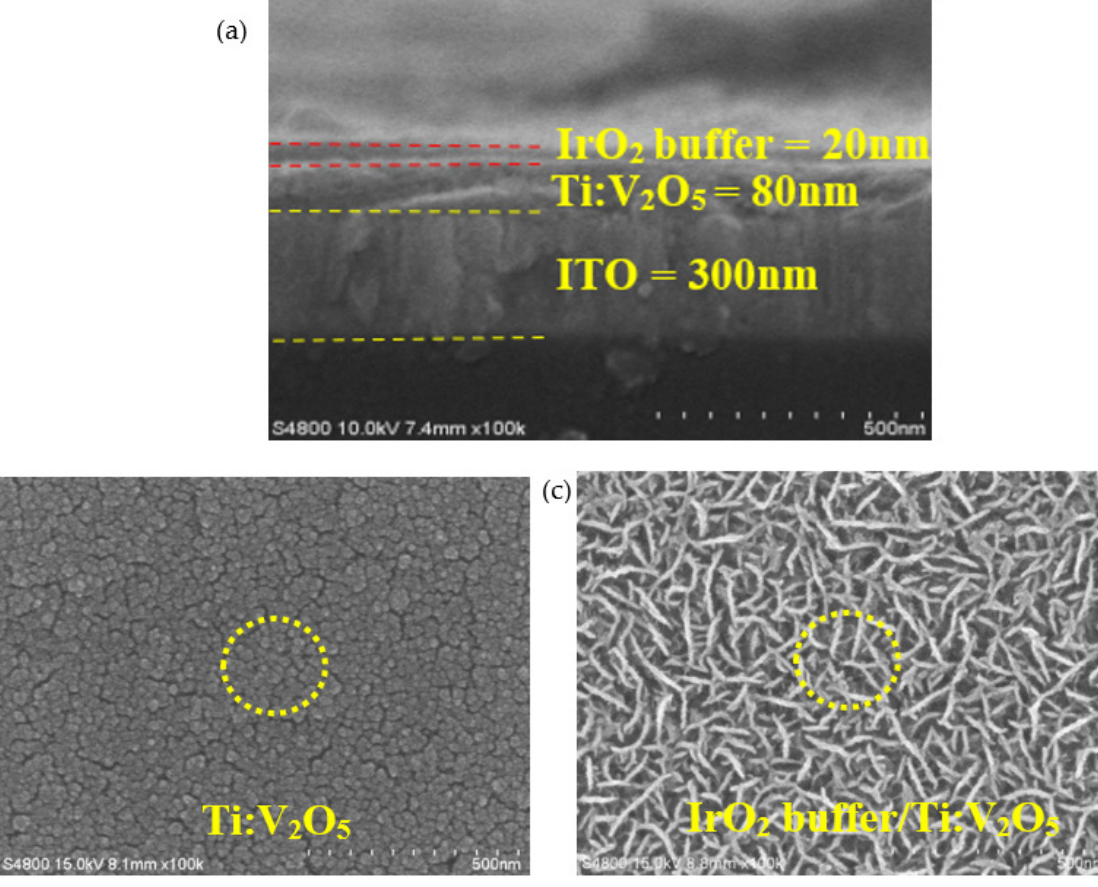
Figure 9. SEM images of surface morphology: ( a ) cross-section morphology of the IrO 2 buffer/Ti:V 2 O 5 film at Ar/O 2 ratio 1/3; ( b ) Ti:V 2 O 5 film at Ar/O 2 ratio 1/3; ( c ) IrO 2 buffer/Ti:V 2 O 5 film at Ar/O 2 gas flow ratio of 1/3.